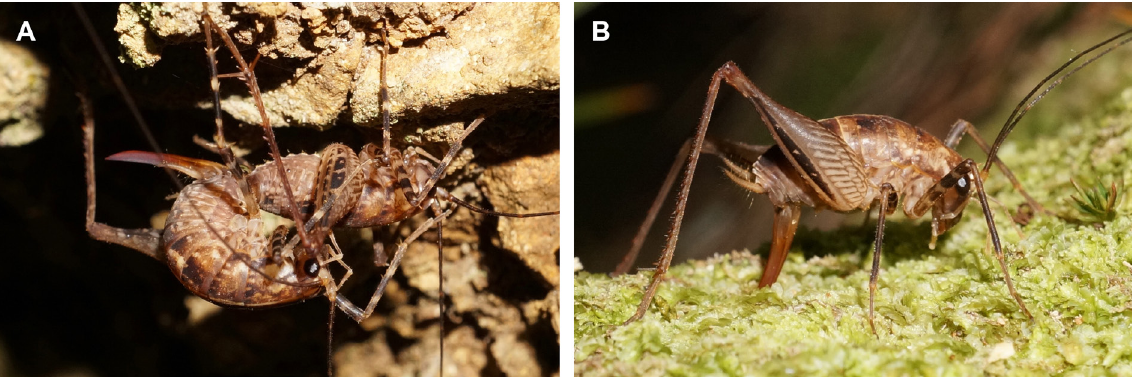
Fig. 19. Pleioplectron hudsoni Hutton, 1896. Live specimens in their natural environment. Zealandia Ecosanctuary, Wellington. A . Mating pair. As in most New Zealand Rhaphidophoridae, the female is on top. B . Adult ♀ egg-laying in rotting